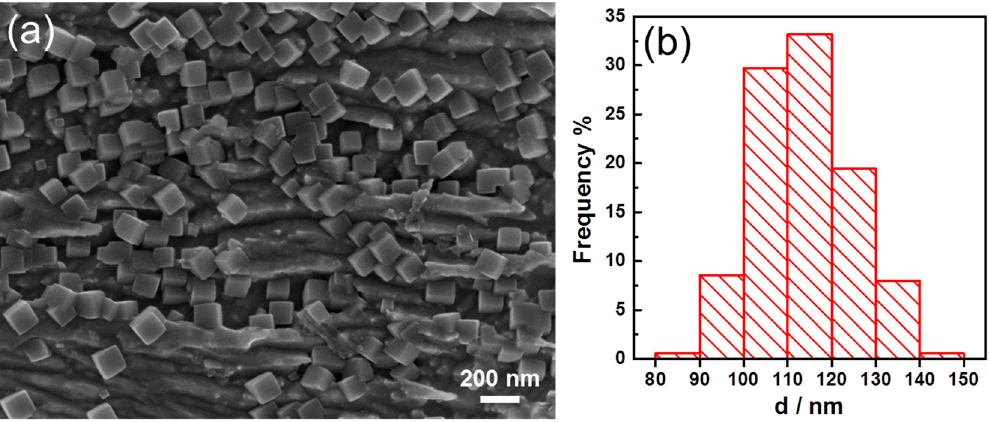
Figure 4. ( a ) SEM of the Iridium nanoparticles synthesized for 30 s. ( b ) Size distribution of the synthesized Iridium nanoparticles.